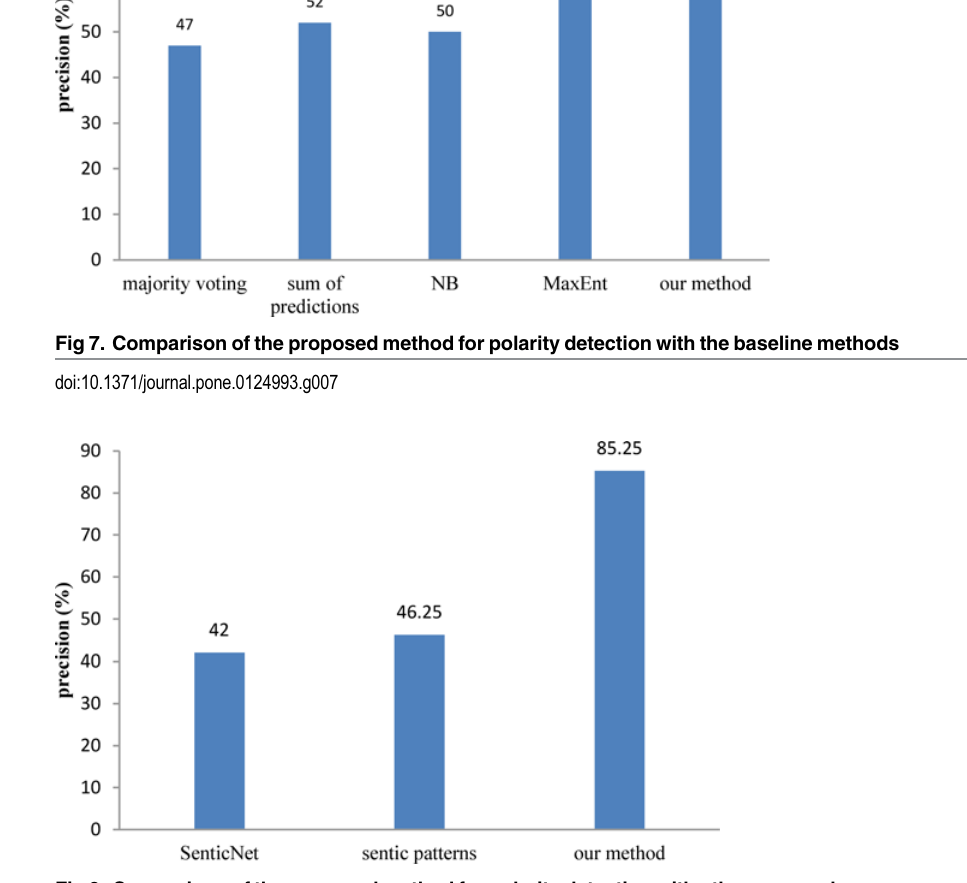
Fig 8. Comparison of the proposed method for polarity detection with other